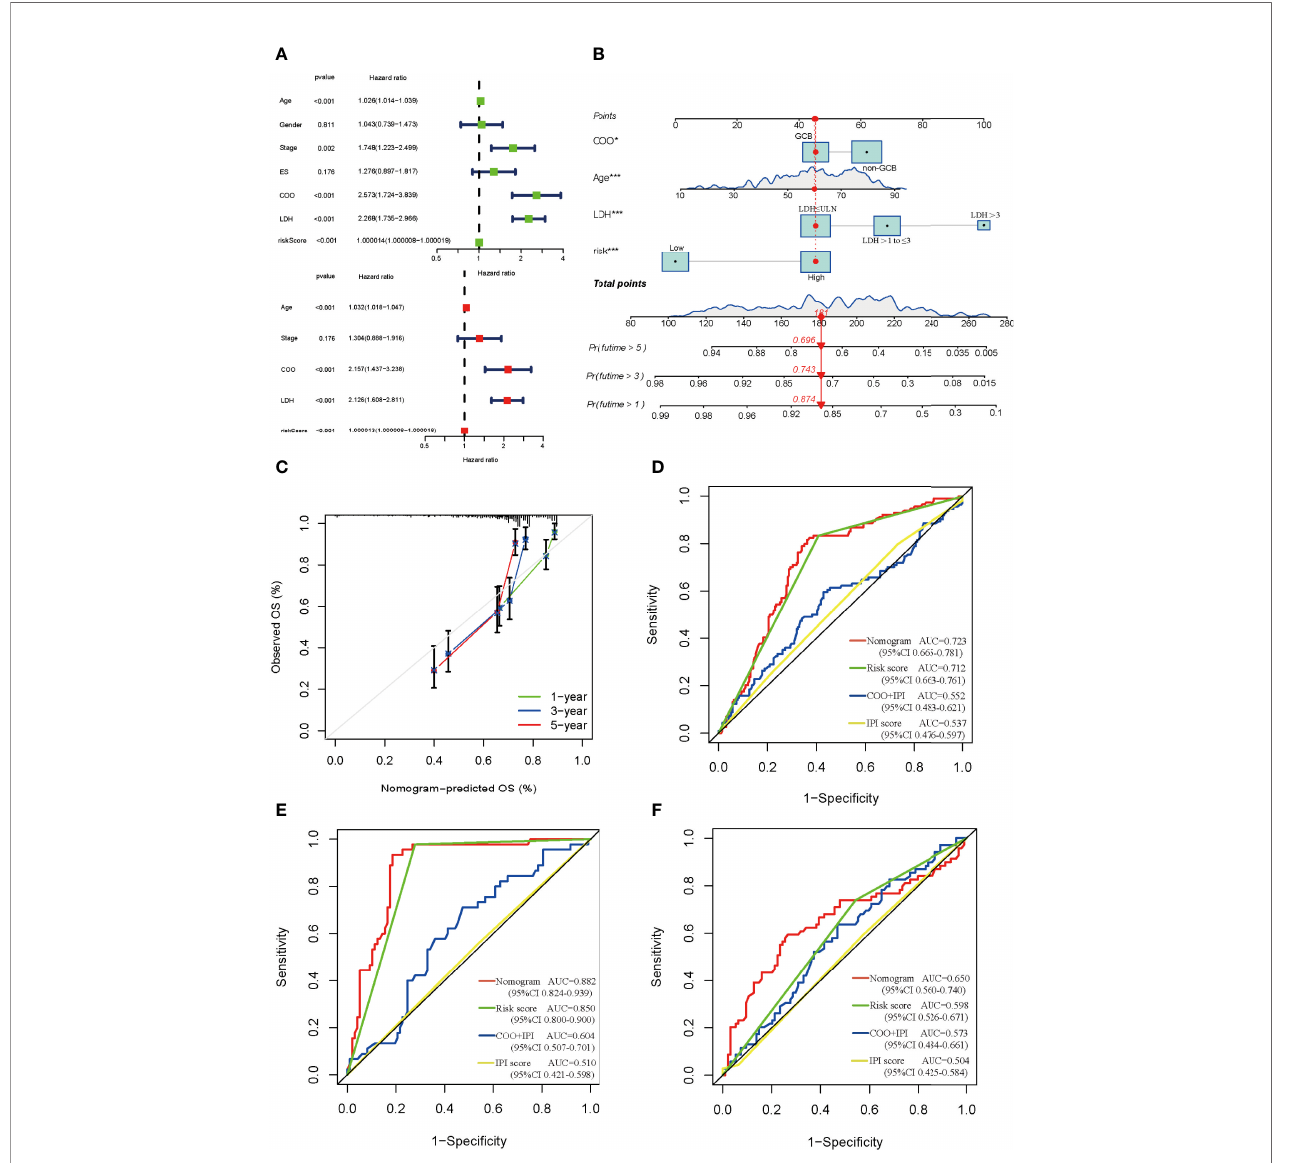
FIGURE 5 | Construction and estimate of nomogram. (A) The univariate (green) and multivariate (red) Cox regression analysis of clinical characteristics and risk score. (B) The nomogram integrating COO, age, LDH, and risk score for DLBCL patients. (C) The calibration curve of the nomogram at 1, 3, and 5 years, respectively. (D) ROC curve of the nomogram, risk score, COO+IPI, and IPI score. ROC curves of the nomogram, risk score, COO+IPI, and IPI score in the CHOP regimen group (E) and RCHOP regimen group (F) . ES, extranodal sites; COO, cell of origin; LDH, lactate dehydrogenases; GCB, germinal center B-cell like; ULN, upper limit of